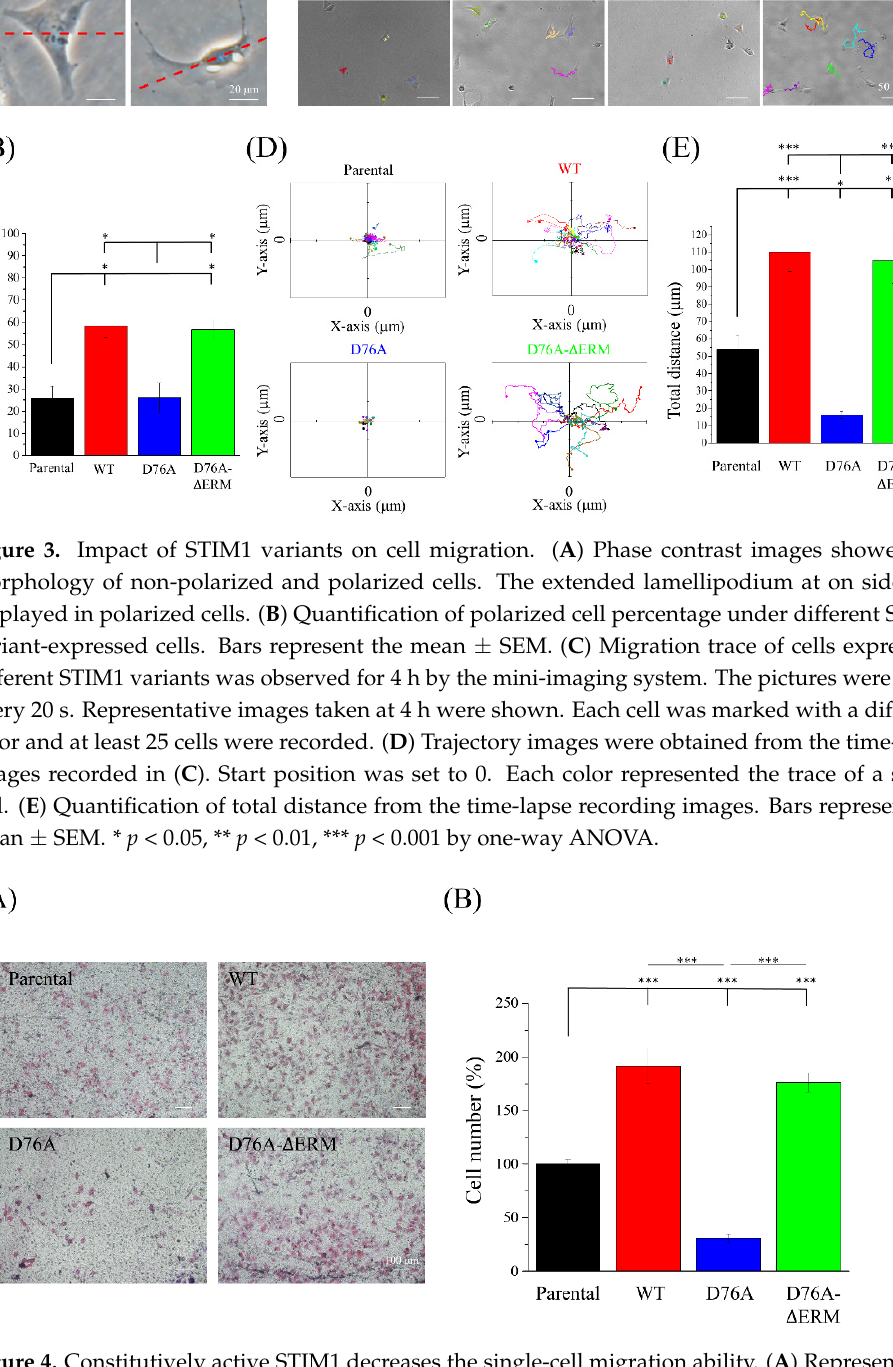
Figure 4. Constitutively active STIM1 decreases the single-cell migration ability. ( A ) Representative images of the transwell single-cell migration assay. Cells that migrated through 0.8 µ m polycarbonate membrane were fixed and stained with the hematoxylin and eosin dye. ( B ) The percentage of migrated cells was quantified from three independent experiments. Bars represent the mean ± SEM. *** p < 0.001 by one-way ANOVA.